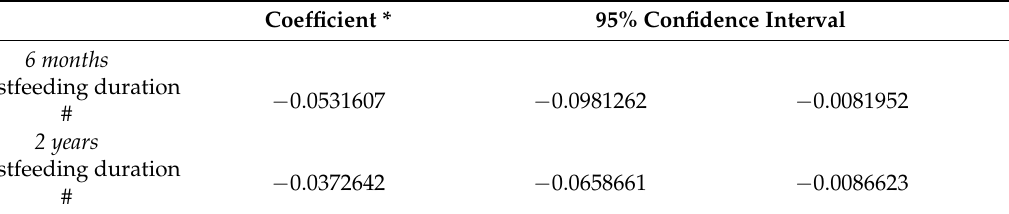
Table 5. Linear regression of total Hg levels (in µ g · g − 1 ) on breastfeeding duration and number